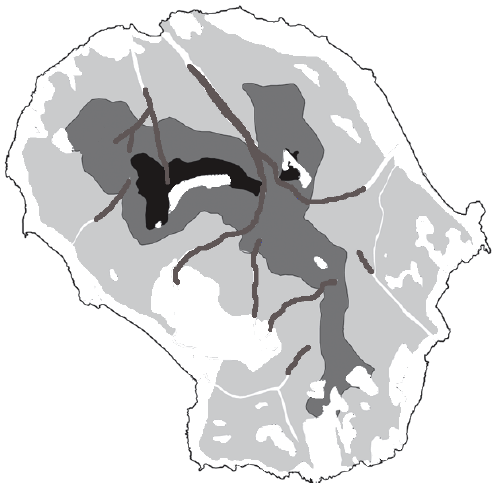
Image 7. Habitats on Silhouette Island, after Senterre et al. 2008 e xcluding areas unsuitable for sooglossids